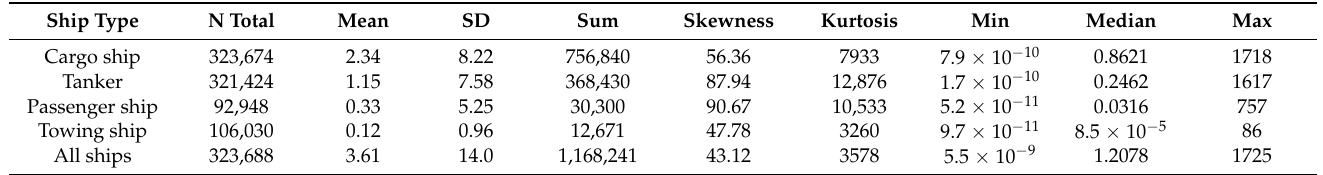
Table 4. Descriptive statistics of density calculation results by ship